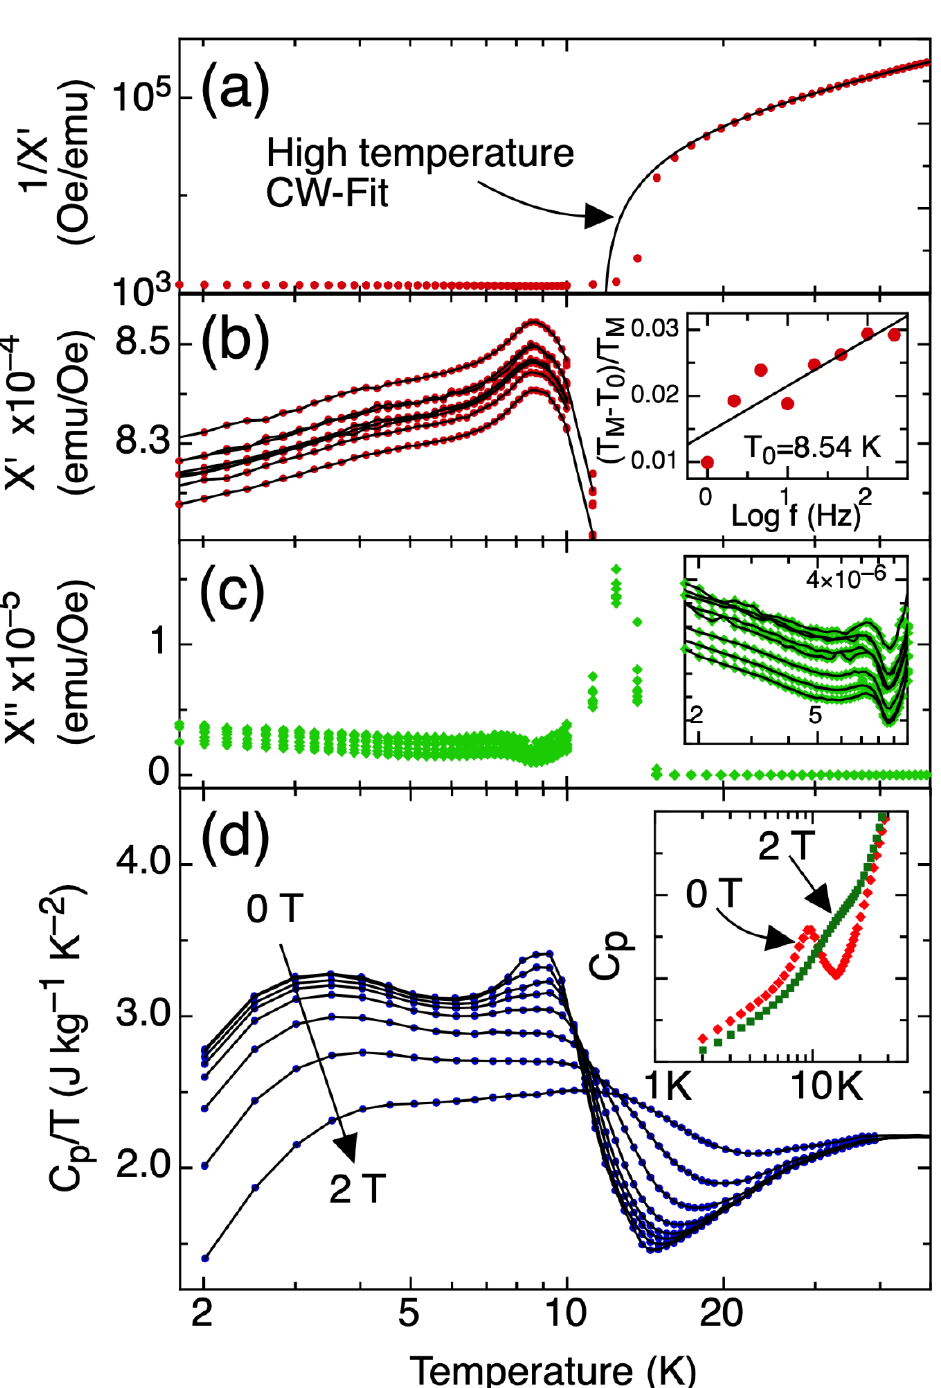
Figure 2. ( a ) The real part of the magnetic susceptibility with a solid line indicating the Curie – Weiss fit to the higher temperature data. ( b ) The real part of the AC magnetic susceptibility at low temperature. Inset: displacement of the peak with frequency. ( c ) The imaginary part of the AC magnetic susceptibility showing a peak at 13 K. Inset: detail of the data below 10 K. ( d ) C p /T as a function of temperature, with C p vs. T in the inset, for applied magnetic fields of up to 2 T. Isobaric heat capacity, C p , as a function of temperature and magnetic field is shown in Figure 2d and indicates clear variation with applied magnetic field. In addition, two distinct regions are observed, corresponding to above and below the zero field maximum at 9 K. The representation of C p /T versus temperature allows one to visualize the evolution of entropy, indicating the relevant features of this phase transition more clearly. Between